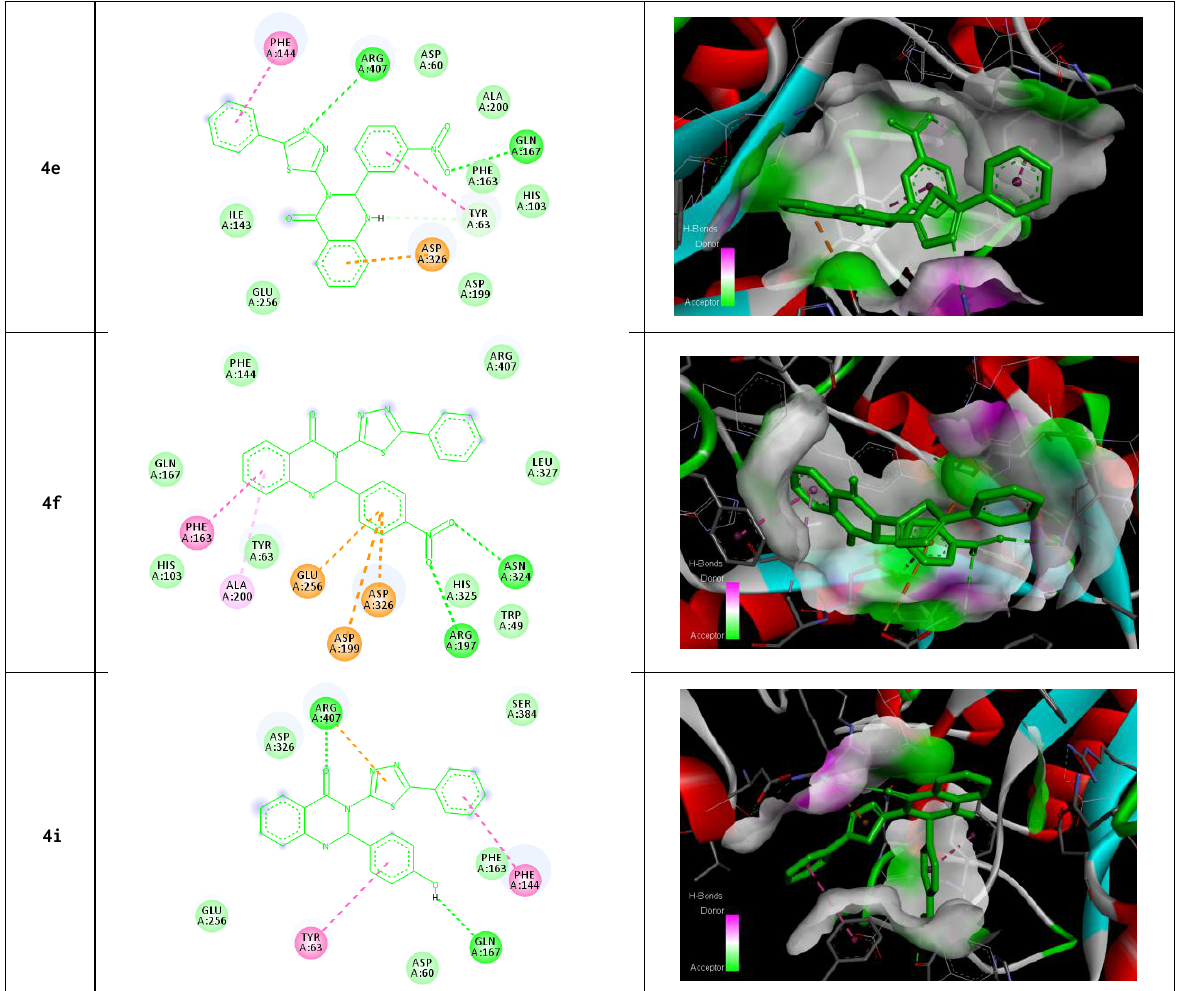
Fig 2. Ligand–Protein 2D and 3D interaction on the active site of 2ze0. 365